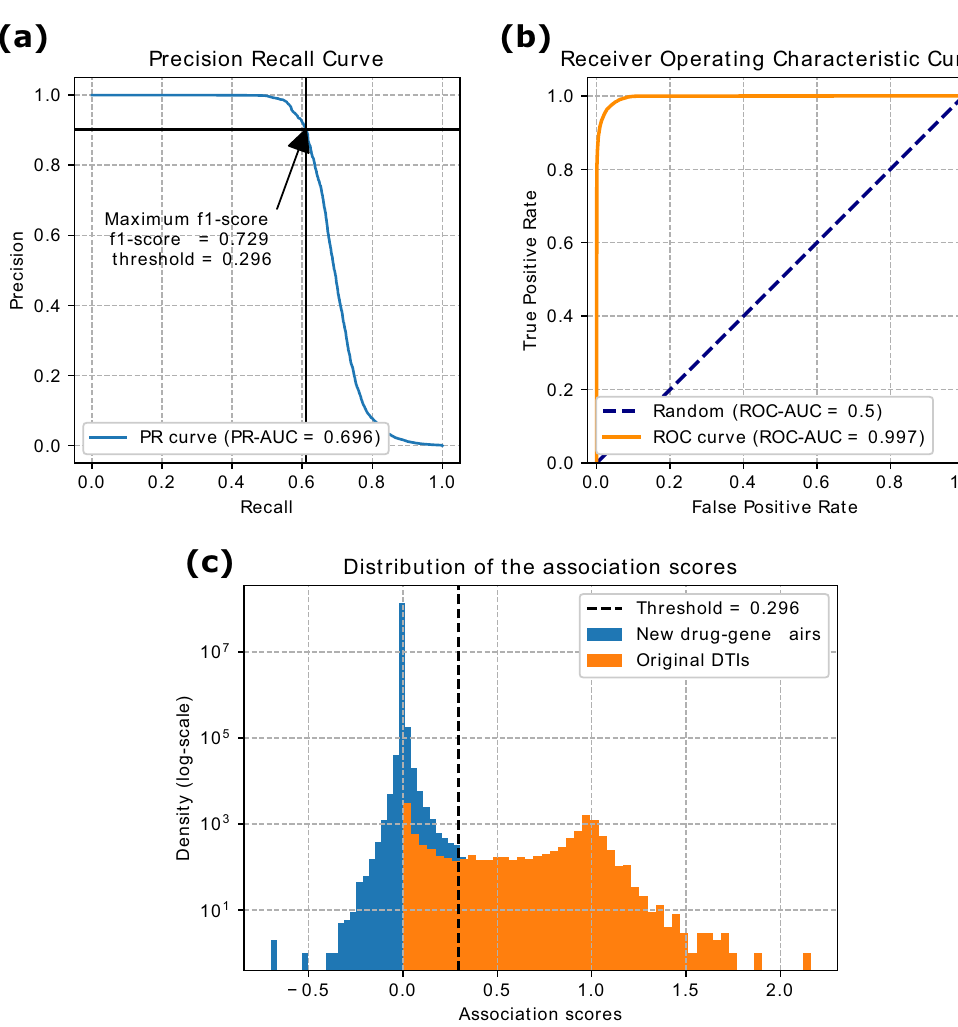
Figure 2. Prediction of new DTIs. (a) Precision-Recall (PR) and (b) Receiver Operating Characteristic (ROC) curves for assessing the ability of the framework to capture the known drug–target interactions accurately. AUC area under the curve. (c) Distribution of the association scores of the reconstructed matrix, for the input DTIs (orange) and the new drug–gene pairs obtained by the matrix completion property of GNMTF (blue). New drug–gene pairs on the right side of the threshold (dashed line) were considered to be newly predicted